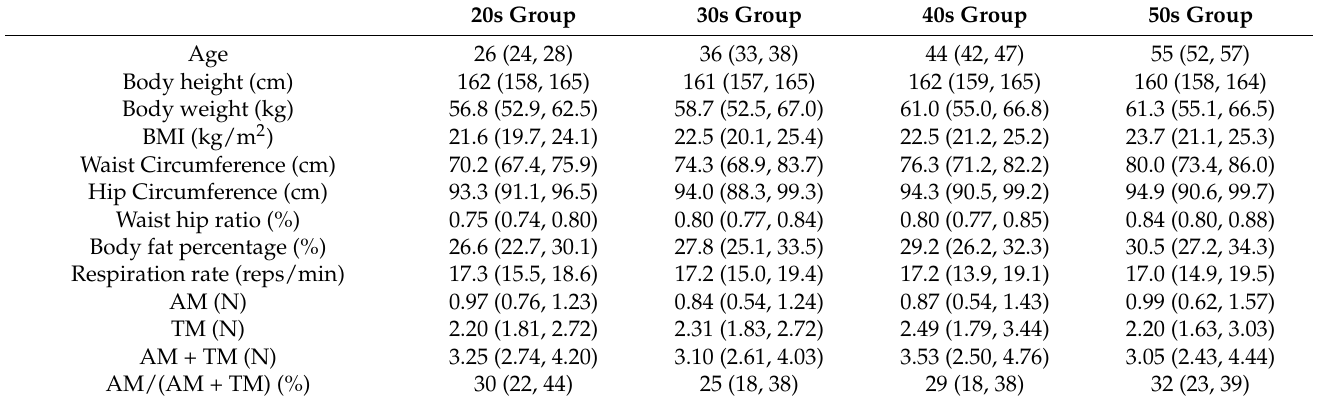
Table 2. Participants’ age, body size, respiratory movements, and physical fitness. 20s